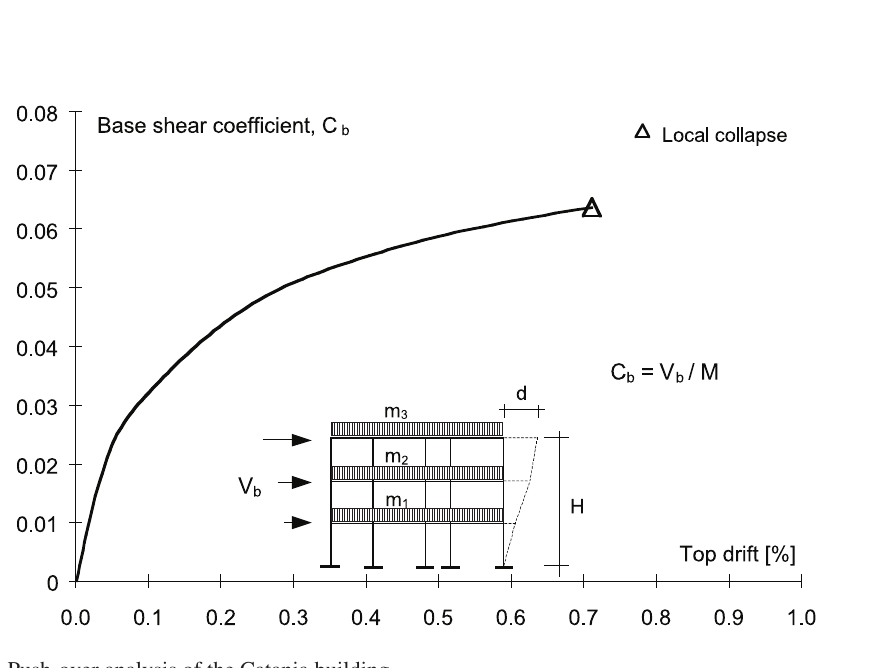
Fig. 11. Push-over analysis of the Catania building.